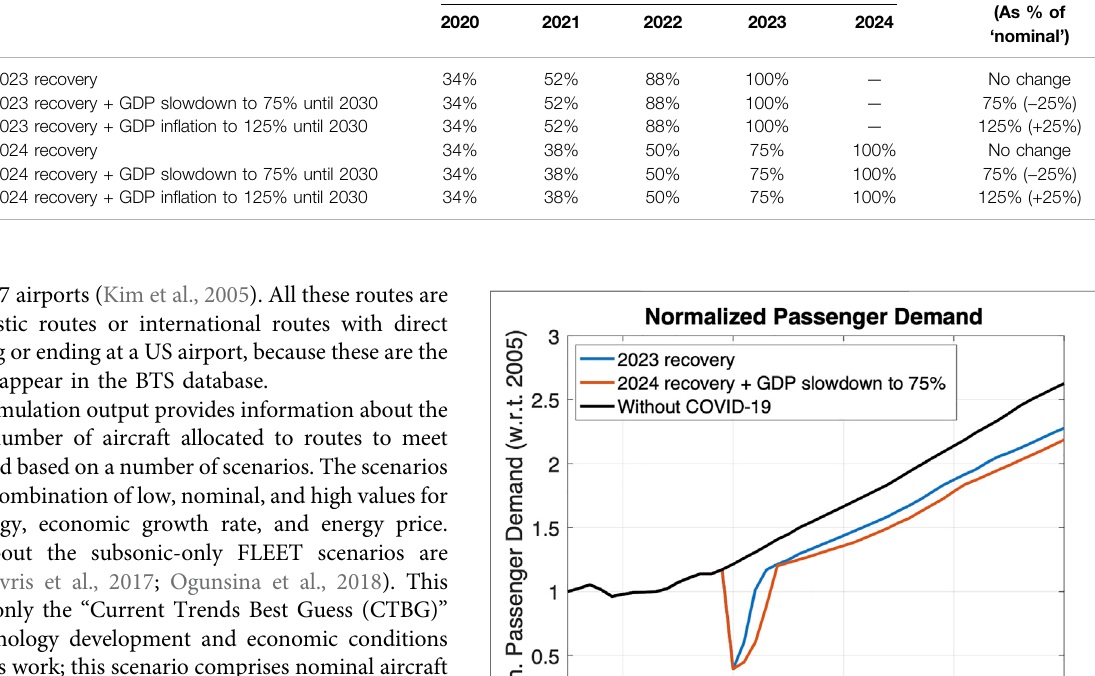
TABLE 4 | Future demand projection scenarios; the ones marked in red font are considered in this study (Jain et al., 2021a). Scenario #